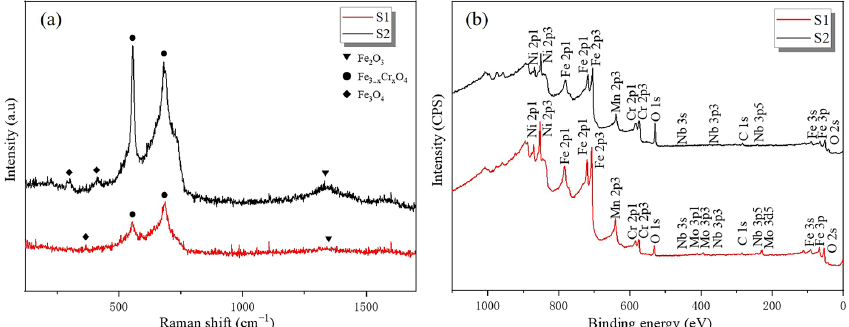
Figure 3. Raman spectra ( a ) and XPS results ( b ) of the investigated samples tested in CO 2 at 650 °C under 3.5 MPa for 1000 h.